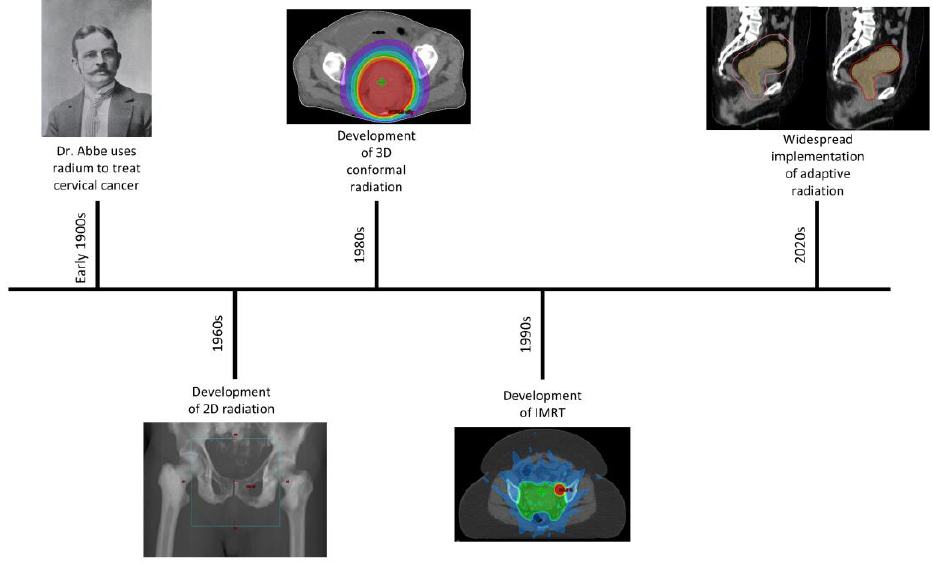
Figure 1. Timeline showing the evolution of radiation in the treatment of GYN cancers.